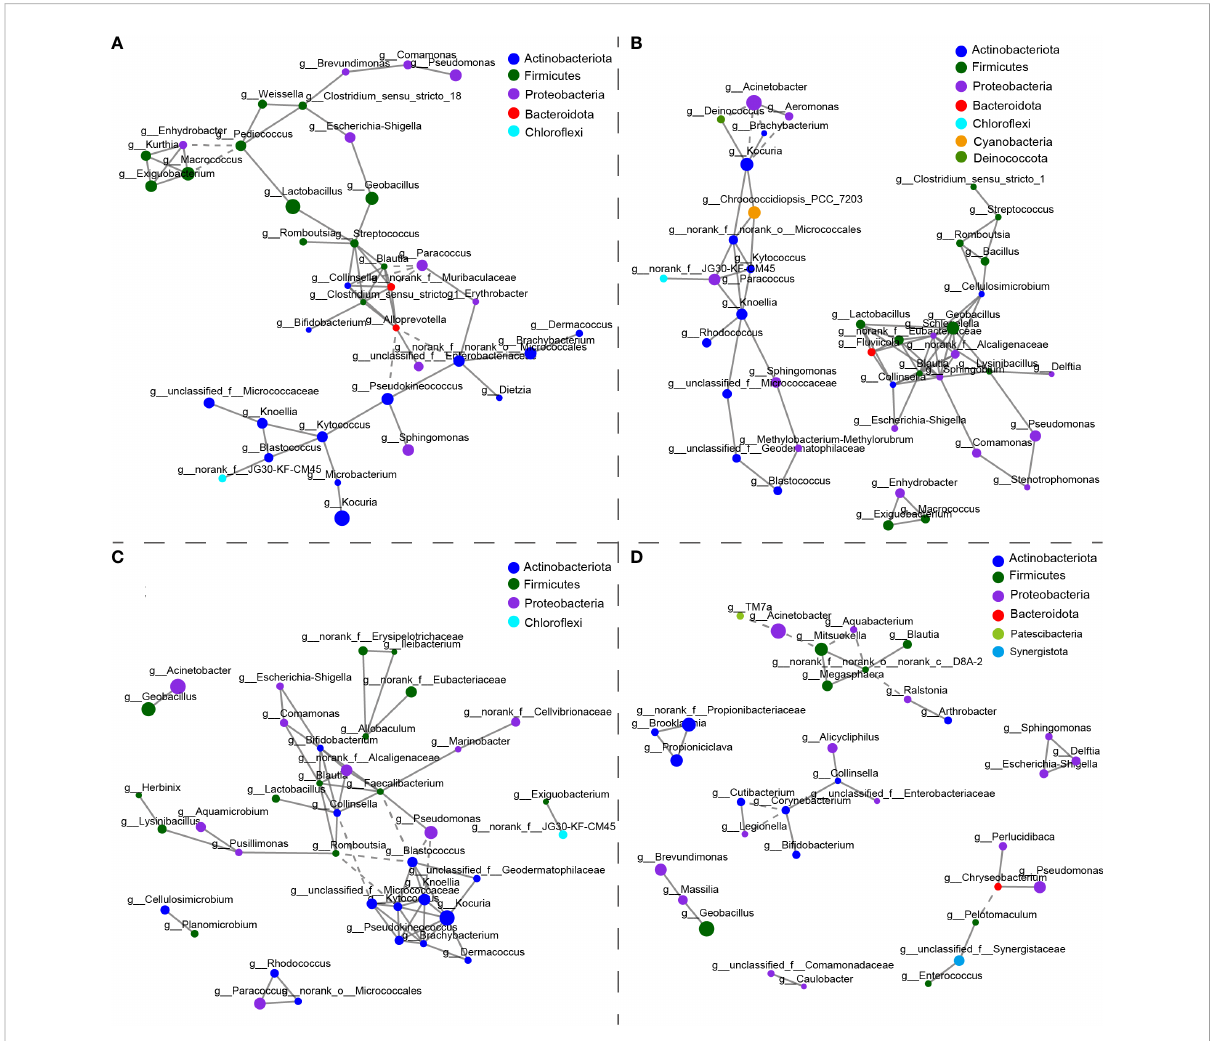
FIGURE 4 The co-occurrence networks of core microbiotas in the (A) skin, (B) oral, (C) gill, and (D) hindgut. The size of the node shows the relative abundance at the genus level. Node color represents taxonomic classi fi cation at the phylum level. Positive interactions are depicted in the solid line and negative interactions in the dashed line. The patterns of networks were measured by Spearman ’ s correlation coef fi cient (r>0.75, p